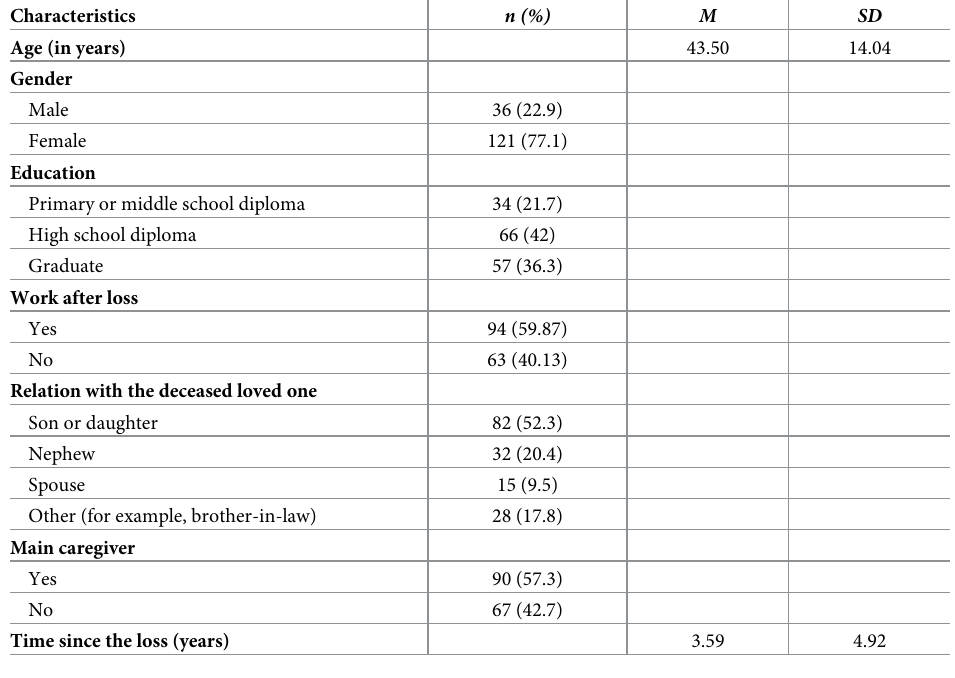
Table 1. Demographic and loss characteristics of the sample ( N =